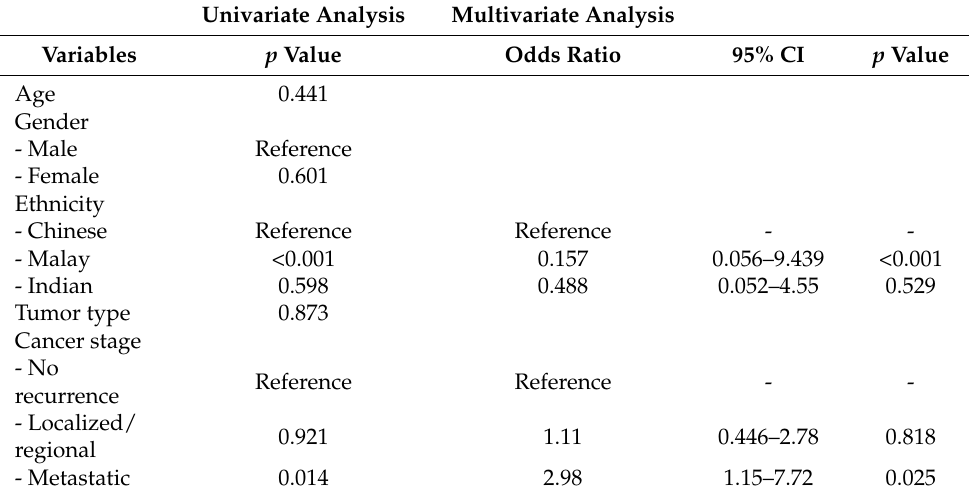
Table 3. Associations with low health-related quality of life scores ( N =